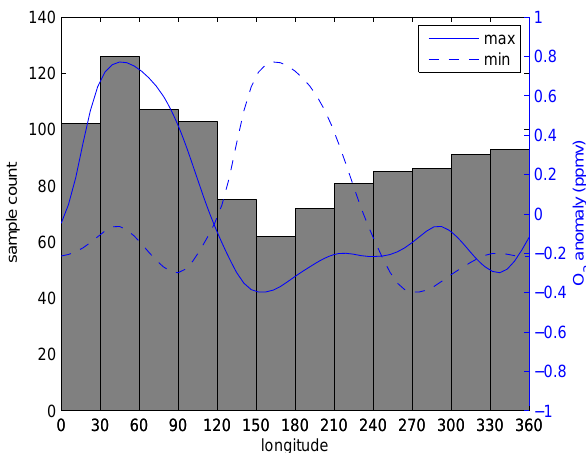
Fig. 8. Zonal MIPAS-LR sampling distribution for March within the 50–55 ◦ N latitude bin (gray bars). Also shown is the monthly mean zonal O 3 anomaly field at 52.4 ◦ N, at 20hPa. The O 3 field has been shifted in longitude to produce maximum (solid) and min- imum (dashed) values of a weighted mean of the O 3 field using the sample distribution as